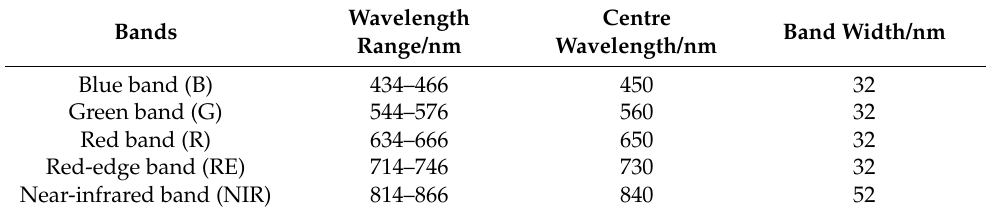
Table 1. Band parameters of multispectral